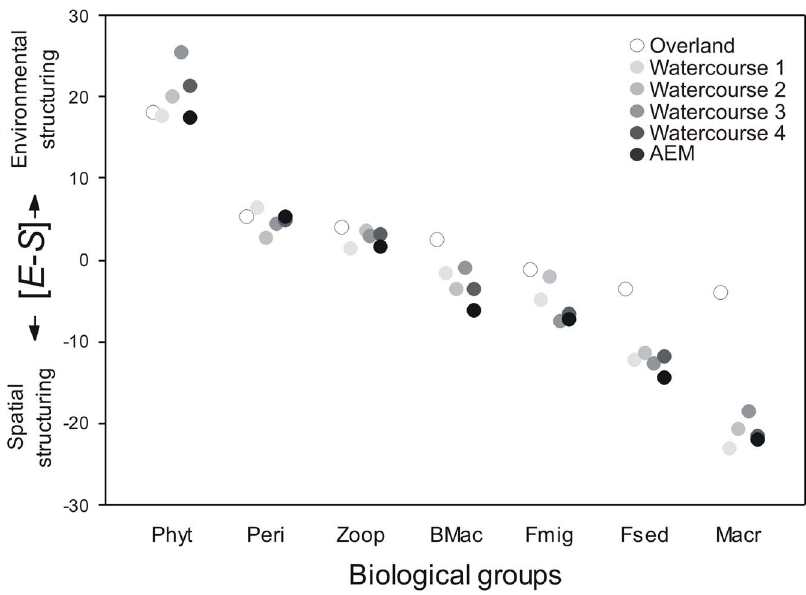
Figure 3. Difference in the contribution of environmental ( E ) and spatial variables ( S ) for the different biological groups, ranked according to the presumed dispersal ability. Different distance matrices were used to generate spatial predictors (one overland and four watercourse distances). E is the fraction of variation in community structure explained by environmental variables that are neither spatially nor temporally structured; S is the spatial patterns in the biological data that are independent of any temporal or environmental predictors. Phyt=phytoplankton; Peri=periphyton; Zoop=zooplankton; BMac=benthic macroinvertebrates; Fmig=migratory fish; Fsed=sedentary fish; Macr=macrophytes.